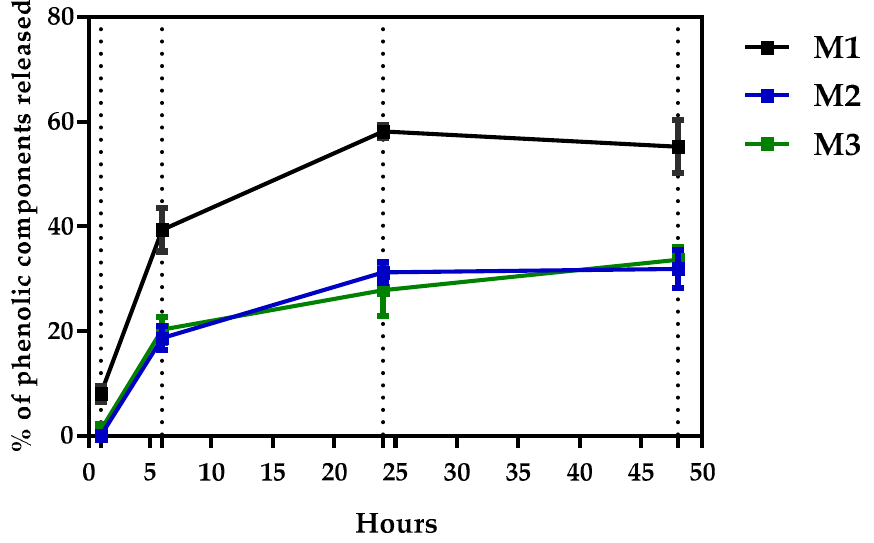
Figure 4. Percentage of the release of the phenolic components of the RPE trapped in the hydrogel matrix of M1, M2 and M3.